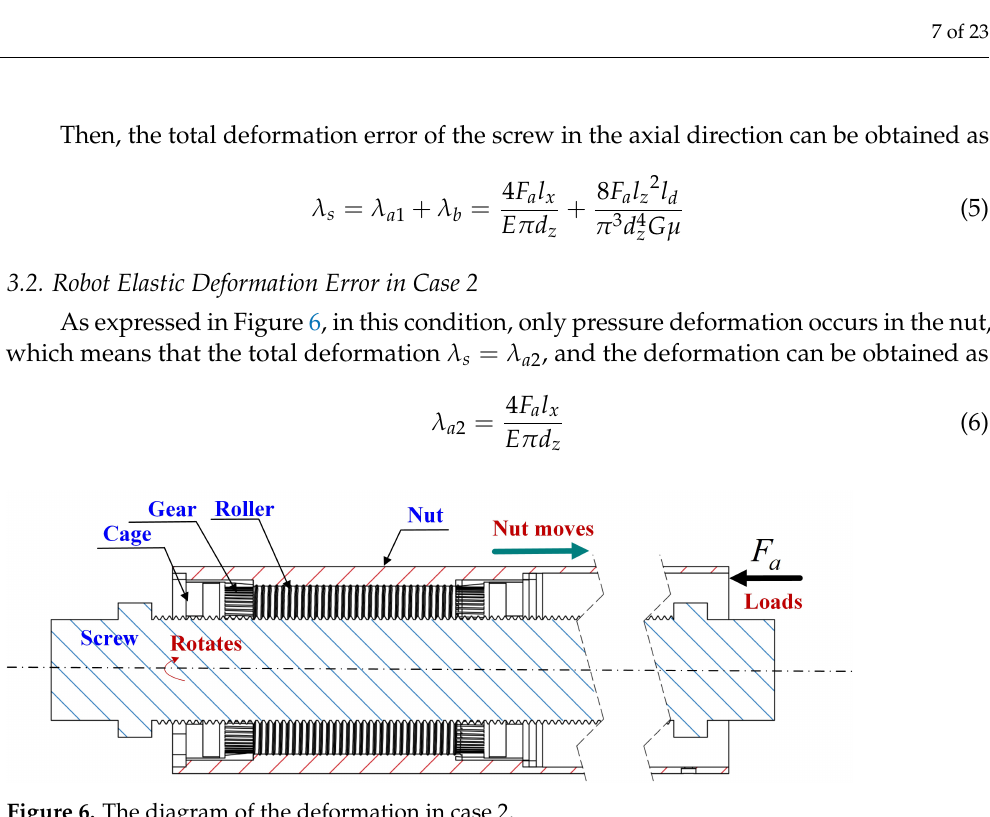
Figure 6. The diagram of the deformation in case